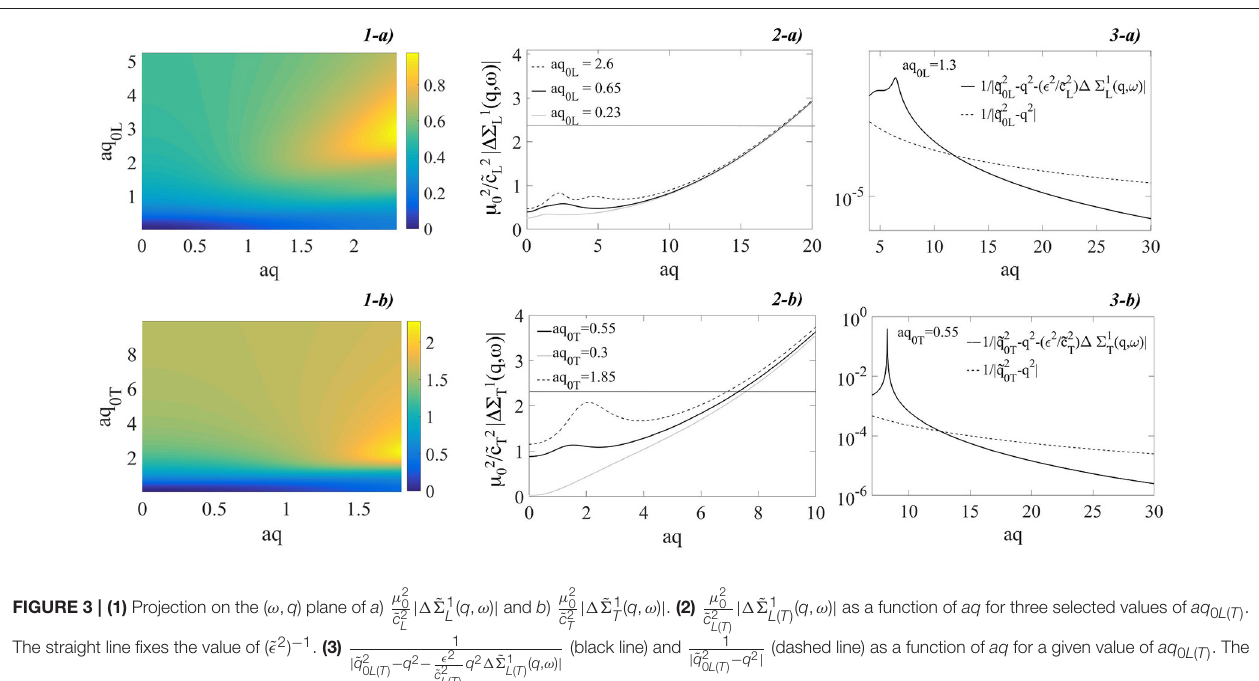
covariance function is cast in an exponential decay function. The values of the theory’s input parameters are listed in the text.